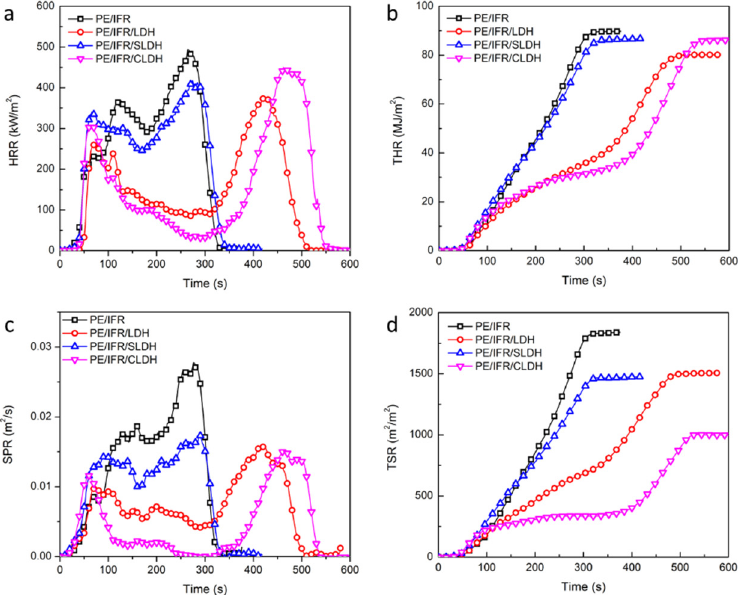
Figure 4. The results of CONE, ( a ) HRR curves, ( b ) THR curves, ( c ) SPR curves, and ( d ) TSR curves.